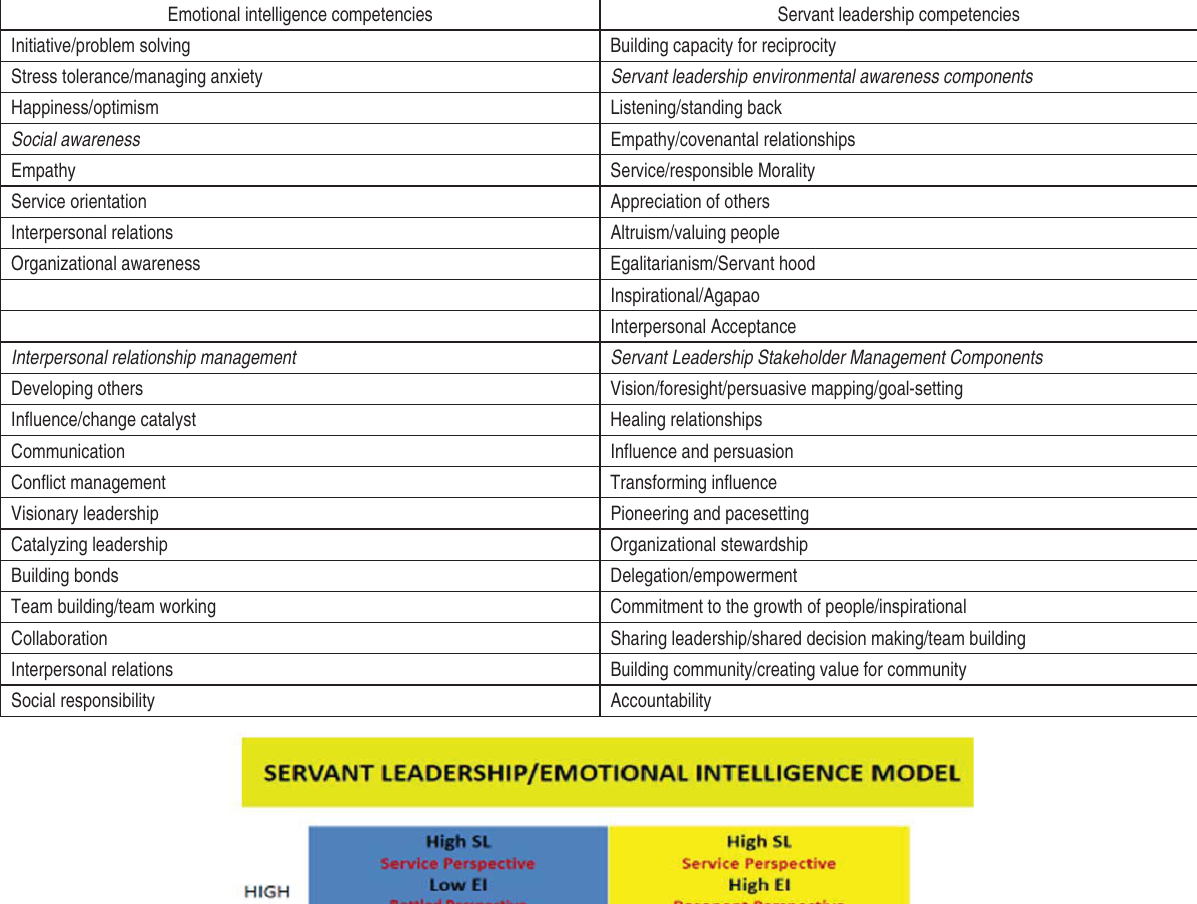
Table 1 (cont.). Proposed integration of emotional intelligence and servant leadership skills